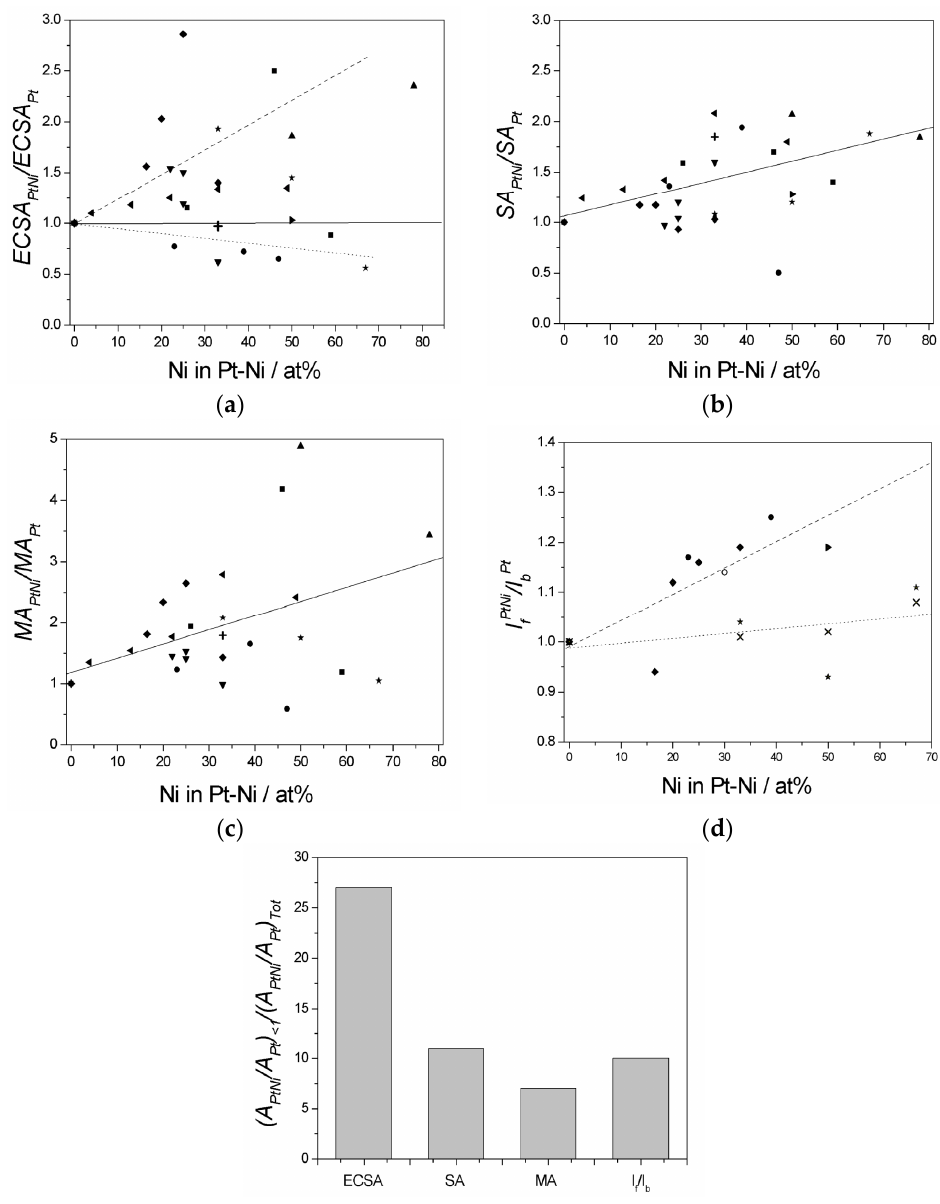
Figure 1. Dependence of the Pt-Ni to Pt electrochemically active surface area ( ECSA Pt-Ni /ECSA Pt ) ( a ); MOR specific activity ( SA Pt-Ni /SA Pt ) ( b ); MOR mass activity ( MA Pt-Ni /MA Pt ) ( c ) and ( I f /I bPt-Ni /I f /I bPt ) ( d ) ratios in acid media on Ni content in Pt-Ni catalysts with various alloying degrees by different datasets; Histogram of ( A PtNi /A Pt ) <1 /( A PtNi /A Pt ) Tot ratios (A = ECSA, SA, MA and I f /I b ), where ( A PtNi /A Pt ) Tot1 and ( A PtNi /A Pt ) <1 are the number of values of the ratio total and lower than 1, respectively ( e ). Symbols in Figure 1a–d: (+) Shen et al. [20]; ( ▲ ) Zhou et al. [21]; ( ◄ )Agrawal et al. [22]; ( ■ ) Wang et al. [37]; ( ● ) Jiang et al. [38]; ( ▼ ) Nassr et al. [39]; ( ♦ ) Hao et al. [40]; ( ► ) Wang et al. [41]; (*) Luo et al. [42]; (X) Hu et al. [43]; (O) Zhou et al. [44].